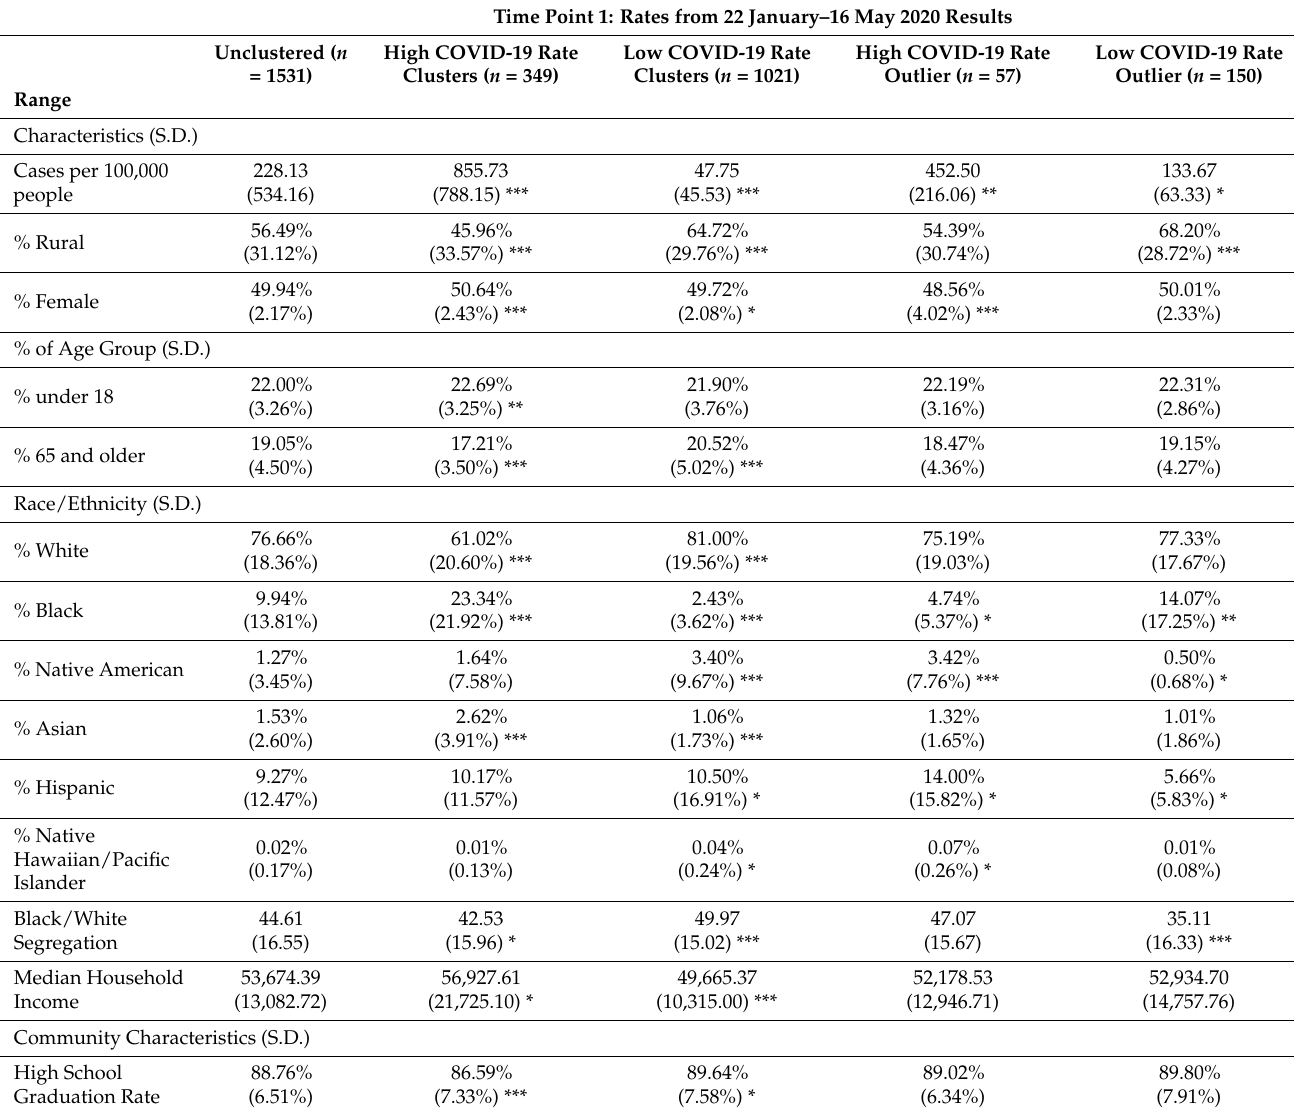
Table 1. County characteristics based on Anselin Moran’s I results for Time Point